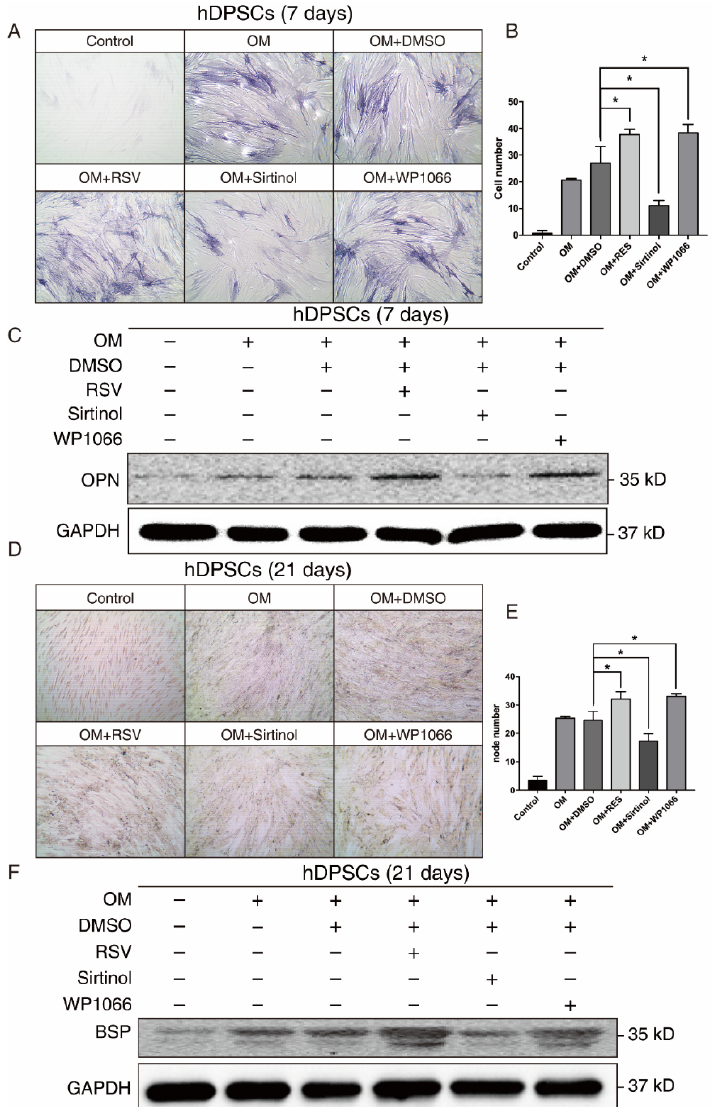
Figure 4. The SIRT1-STAT3 pathway regulated the osteogenic differentiation of hDPSCs at both early and late stages. ( A ) ALP staining showing the osteogenic differentiation potential of hDPSCs at day 7 under indicated conditions. ( B ) Quantitative analysis of the ALP staining activity from ( A ). The null hypothesis of the quantitative analysis was “H0: there is no difference between two groups” . ( C ) Western blot showing the expression levels of early osteogenic marker OPN under indicated conditions. ( D ) Von Kossa staining and the quantitative analysis ( E ) showing the osteogenic differentiation potential of hDPSCs at day 21 under indicated conditions. The null hypothesis of the quantitative analysis was also “H0: there is no difference between two groups” . ( F ) Western blot showing the expression levels of late osteogenic marker BSP under indicated conditions. OM: Osteogenic induction medium, RSV: Resveratrol. * p <